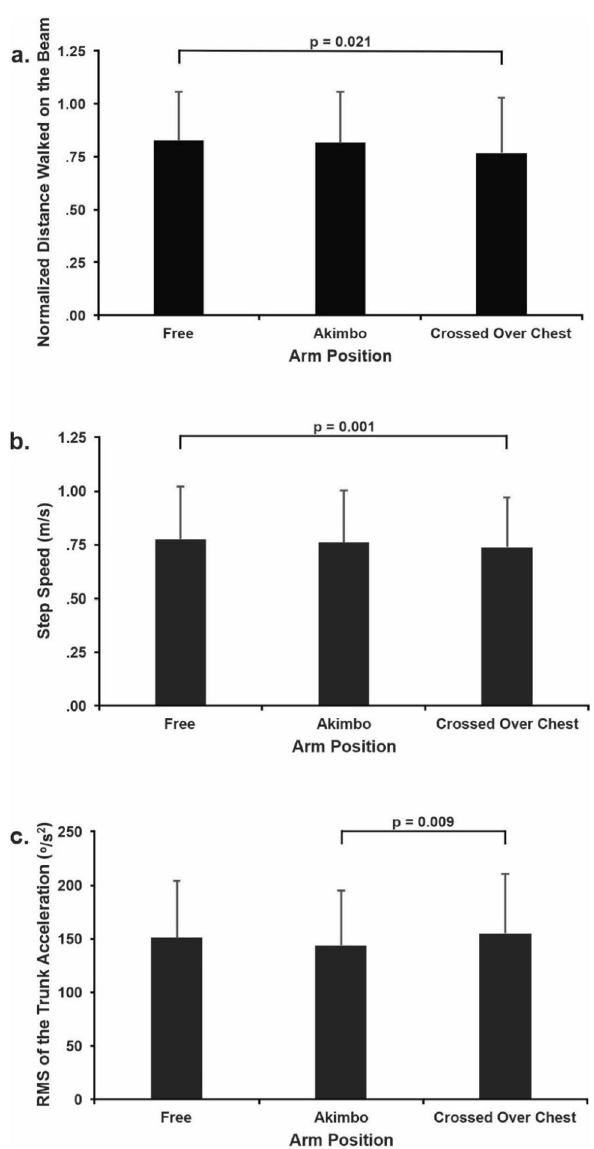
Figure 3. Mean and standard deviation of the arm position main effect for the normalized walking distance on the beam ( a ), step speed ( b ), and RMS of the trunk acceleration ( c ). The horizontal lines indicate pairwise differences with the respective p -value.